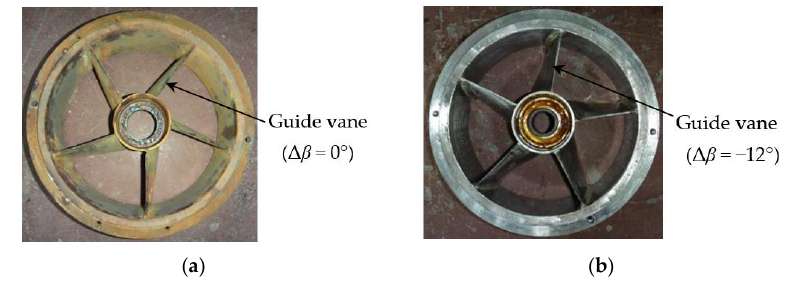
Figure 9. Photos of model guide vanes, ( a ) ∆ β = 0 ◦ , ( b ) ∆ β = − 12 ◦